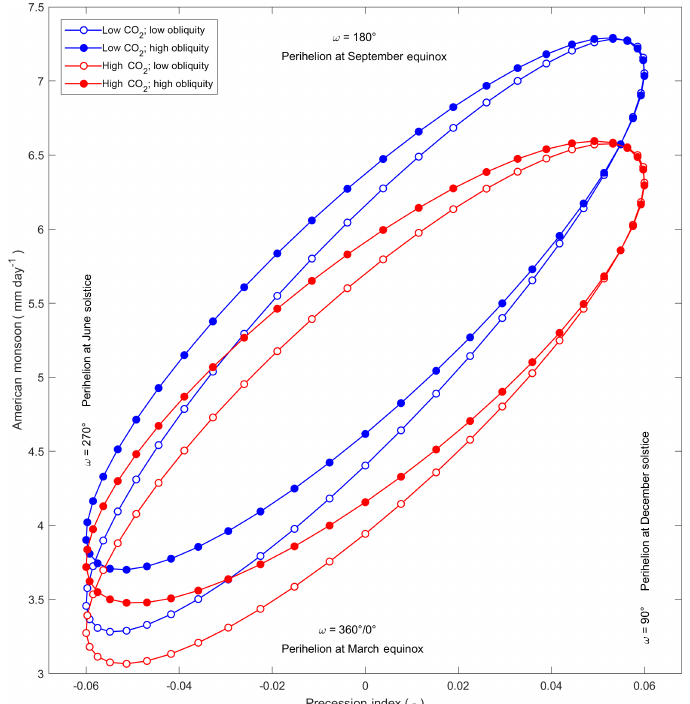
Figure 14. Emulated values of the American monsoon index, for the full range of the precession index ( e sin ω ), at low and high values of CO 2 and obliquity ( ε